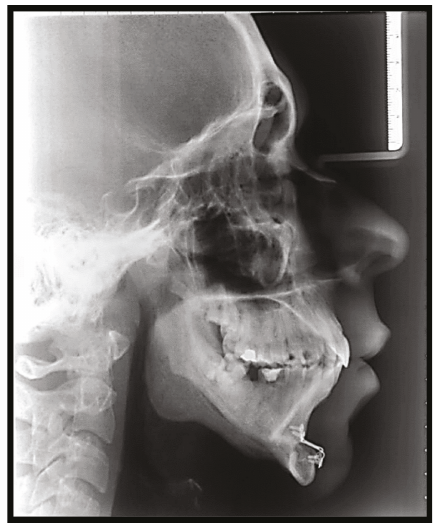
Figure 19: Pro fi le teleradiograph after two years showing stability in the fi xation and improvement of the facial pro fi